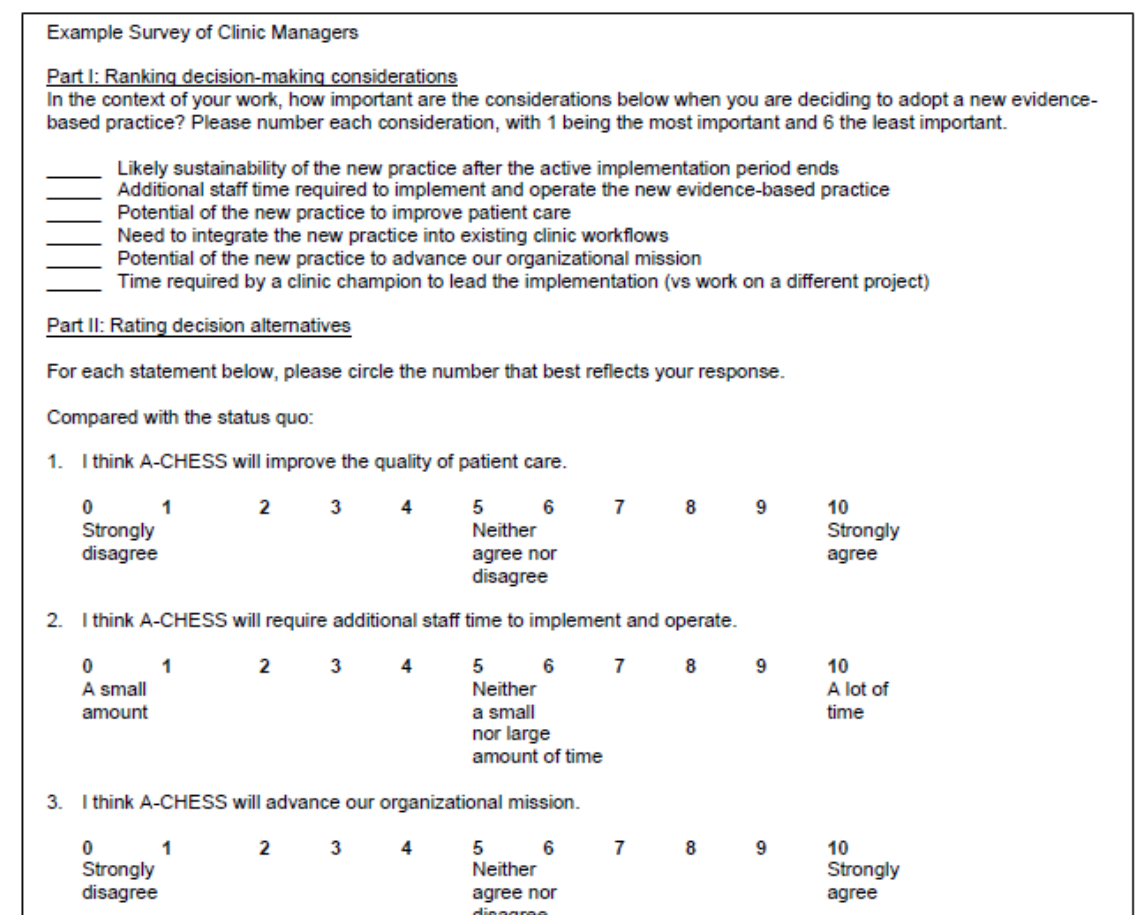
Figure 3. Illustration of prospective ranking and rating